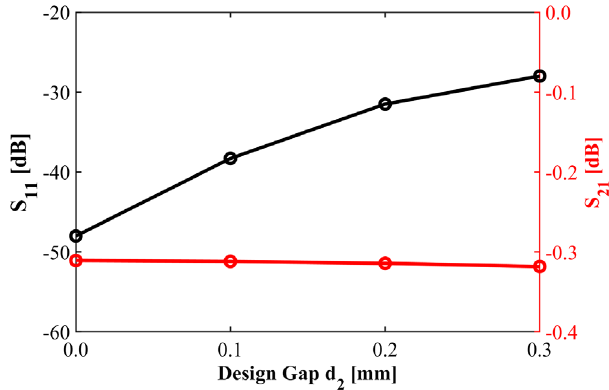
FIG. 8. Simulated S 11 and S 21 as a function of design gap d 2 .